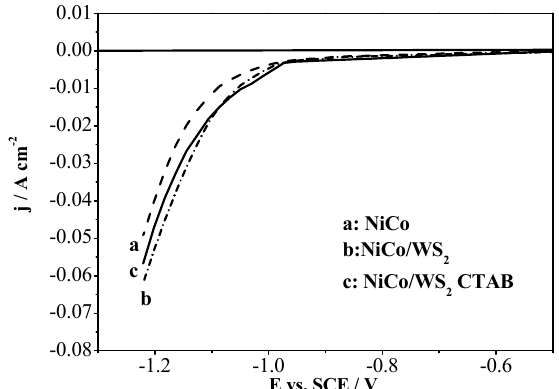
Figure 1. The current density-cathodic potential curves of (state electrode reactions) in Ni–Co and Ni–Co/WS 2 electrolytes.